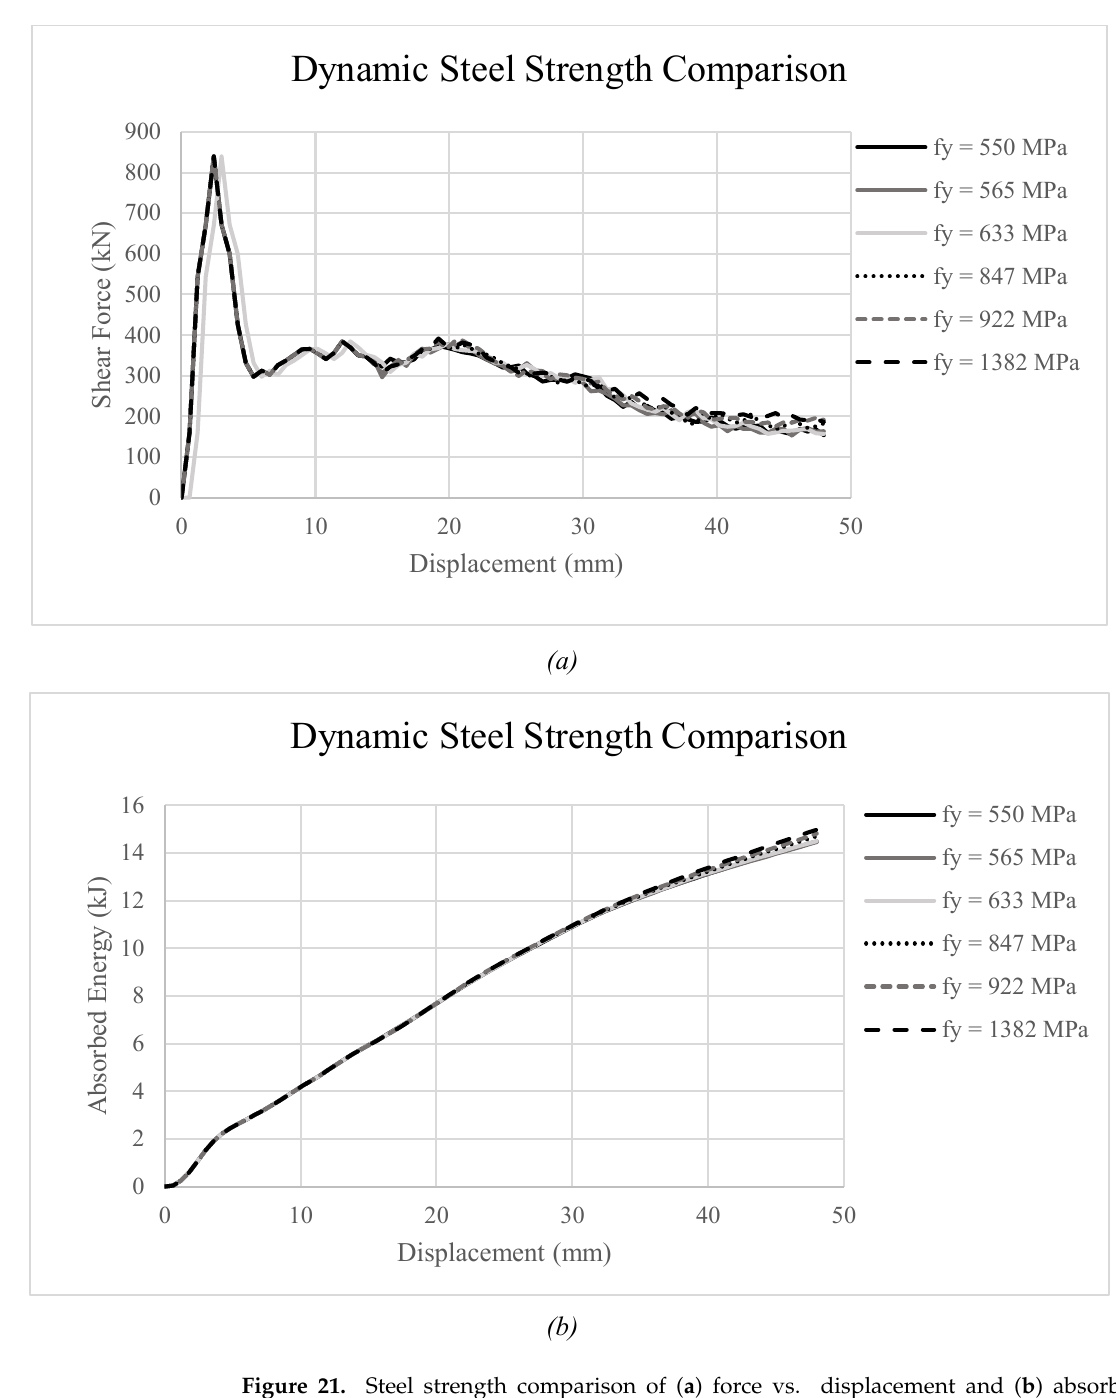
Figure 21. Steel strength comparison of ( a ) force vs. displacement and ( b ) absorbed energy vs. dis ‐ placement.